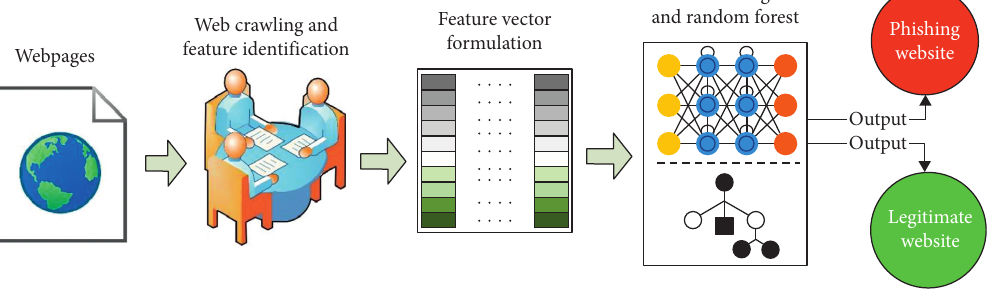
Figure 3: Proposed methodology.